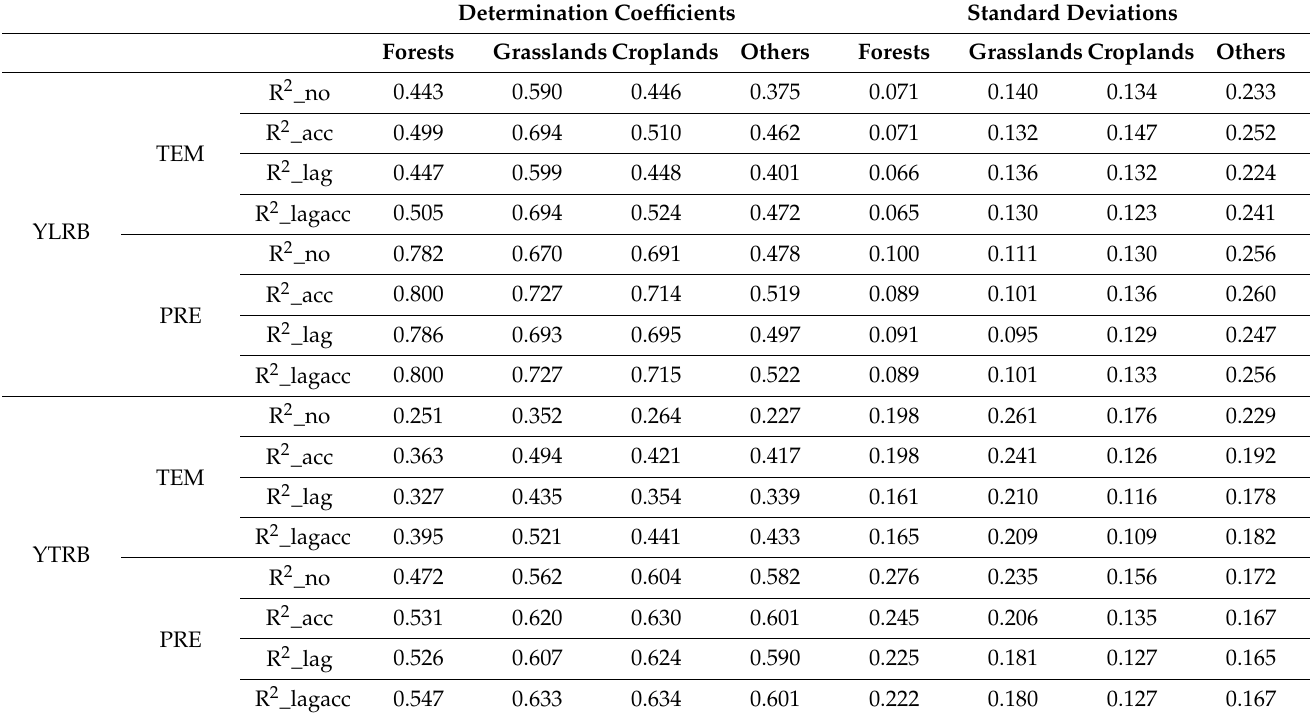
Table 3. Determination coefficients and standard deviations between the NDVI and each climatic fac- tor for the different vegetation types under different scenarios (R 2 _no, R 2 _acc, R 2 _lag, and R 2 _lagacc).